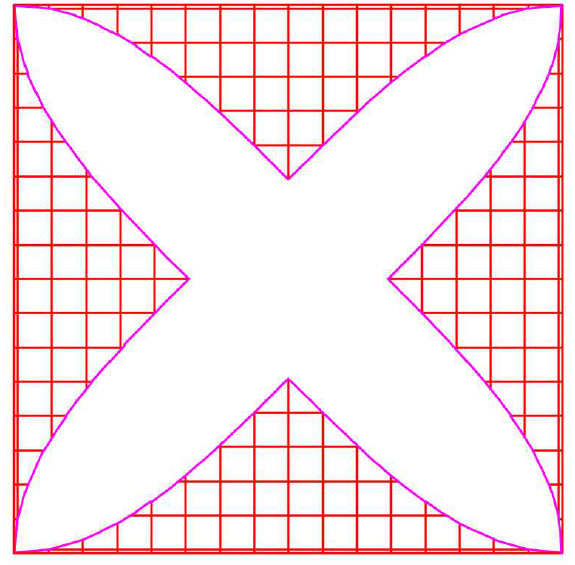
Figure 6. Development of the cross-vault.